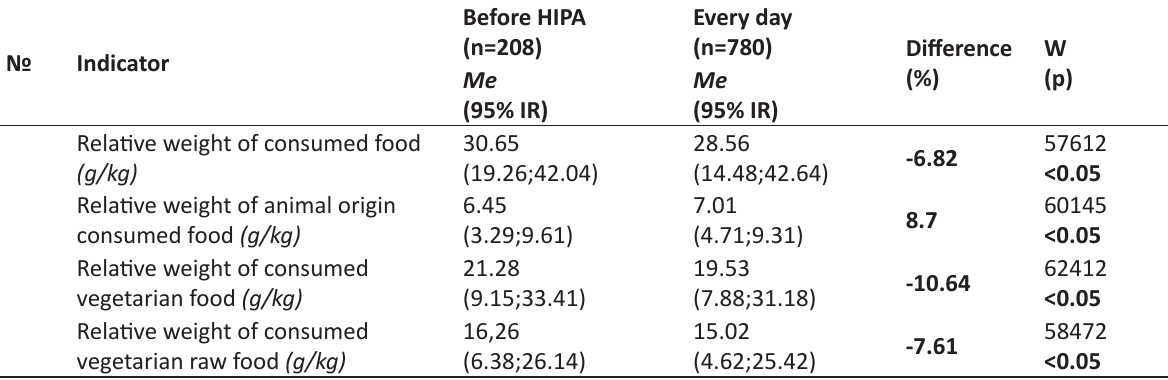
Table 3. Comparison of the consumed by men food products before highly intensive physical activity and every day